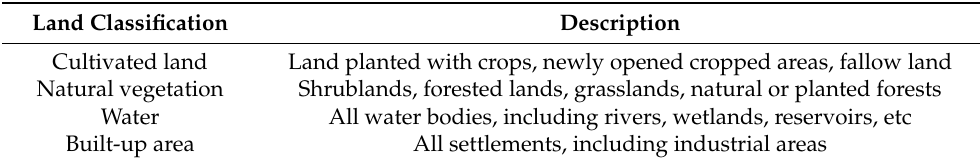
Table 1. Land-cover classification types that were used as training samples. Land Classification Description Cultivated land Land planted with crops, newly opened cropped areas, fallow land Natural vegetation Water Built-up area All settlements, including industrial